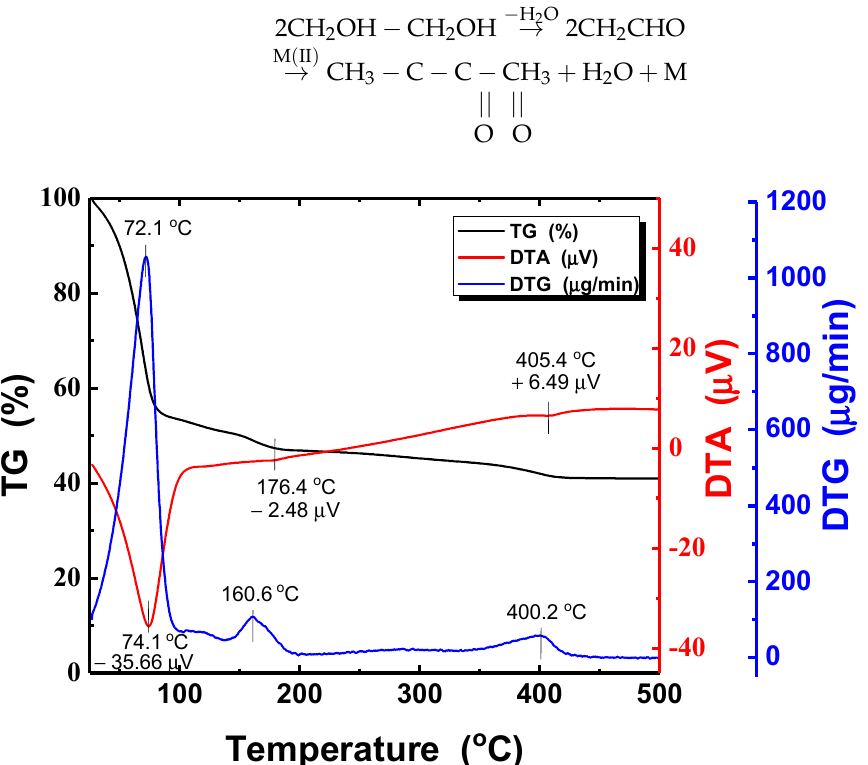
Figure 5. Thermogravimetric (TG), differential thermal analysis (DTA), and derivative thermogravimetric (DTG) of the silver nanoparticle ink.